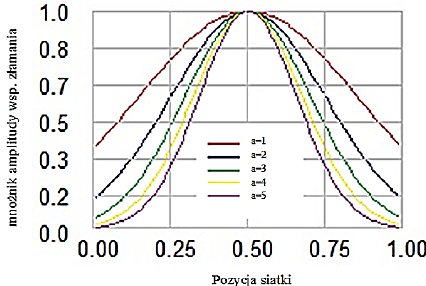
Fig. 6. Gauss apodization profiles for different values of parameter а.